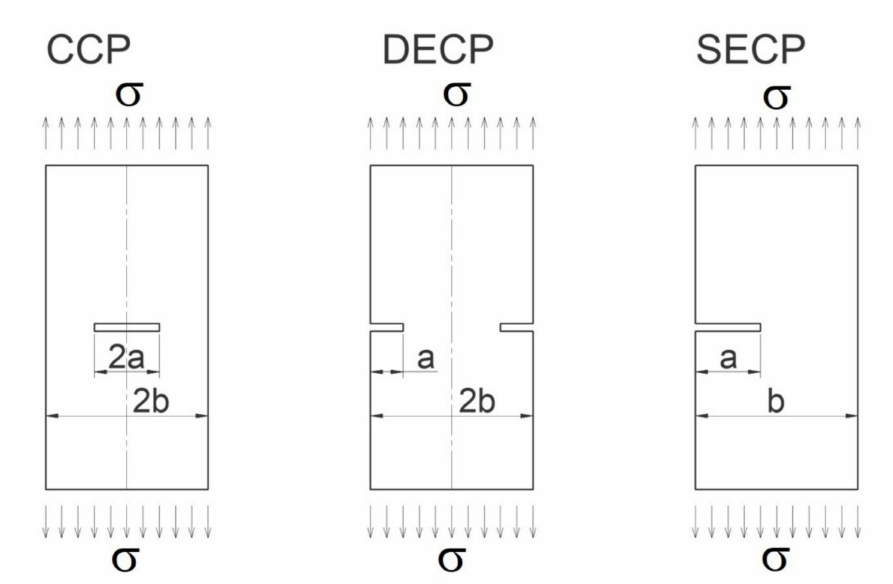
Figure 4. Specimens used in the investigations.